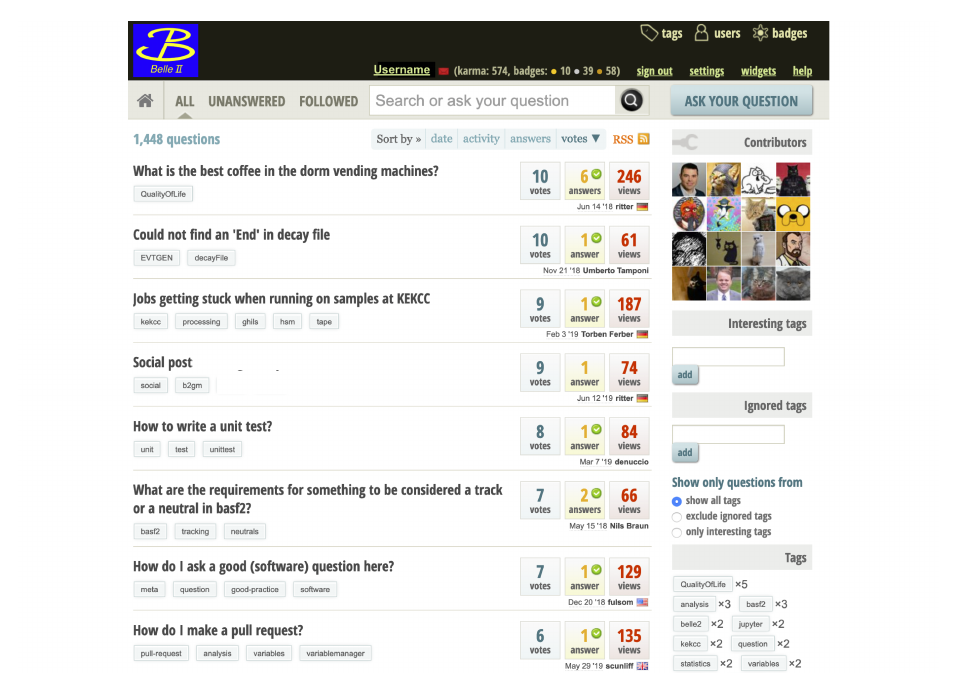
Figure 3. Screenshot of the askbot